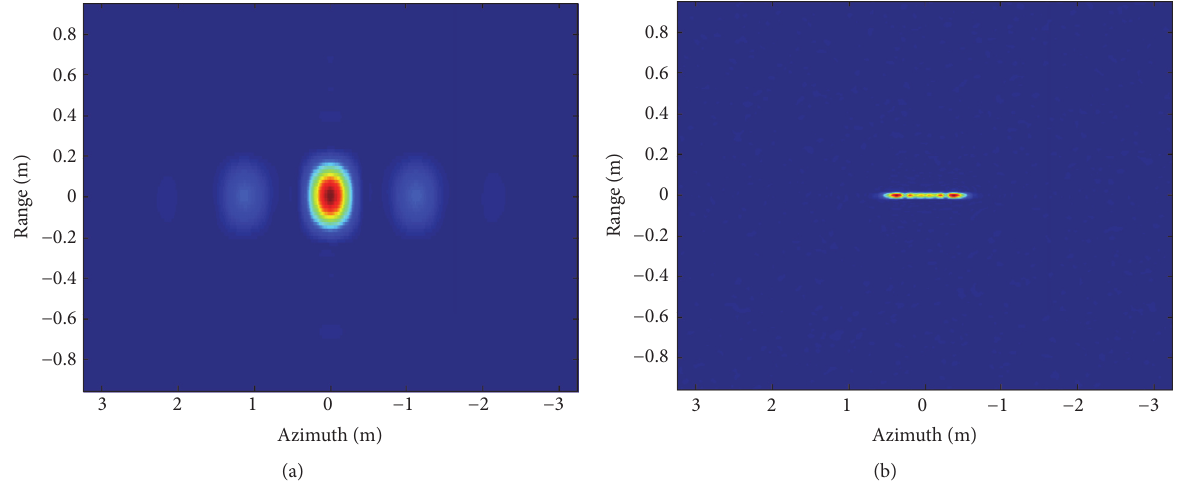
Figure 4: SAR images of a vibrating point target with the vibration amplitude 1mm and frequency 1 Hz without refocusing: (a) X-band; (b) THz band (220 GHz).